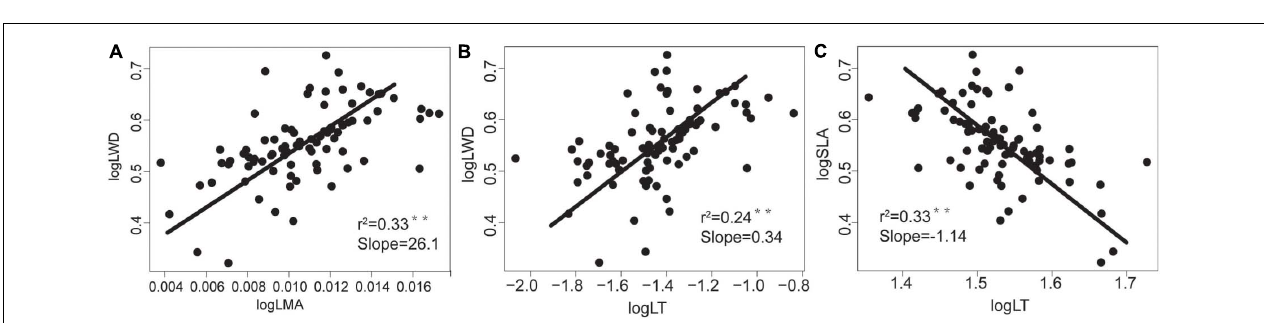
FIGURE 2 | The relationships between nutrient functional traits (N, P concentration) of tree species’ above- and belowground vegetative organs in the tropical cloud forest. The slope values and P -values for (A) RP-WP, (B) RP-LP, (C) RN-LN, and (D) RN-WN derived from SMA analyses. * and ** indicate significant correlations at the levels of P < 0.05 and P < 0.01, respectively.